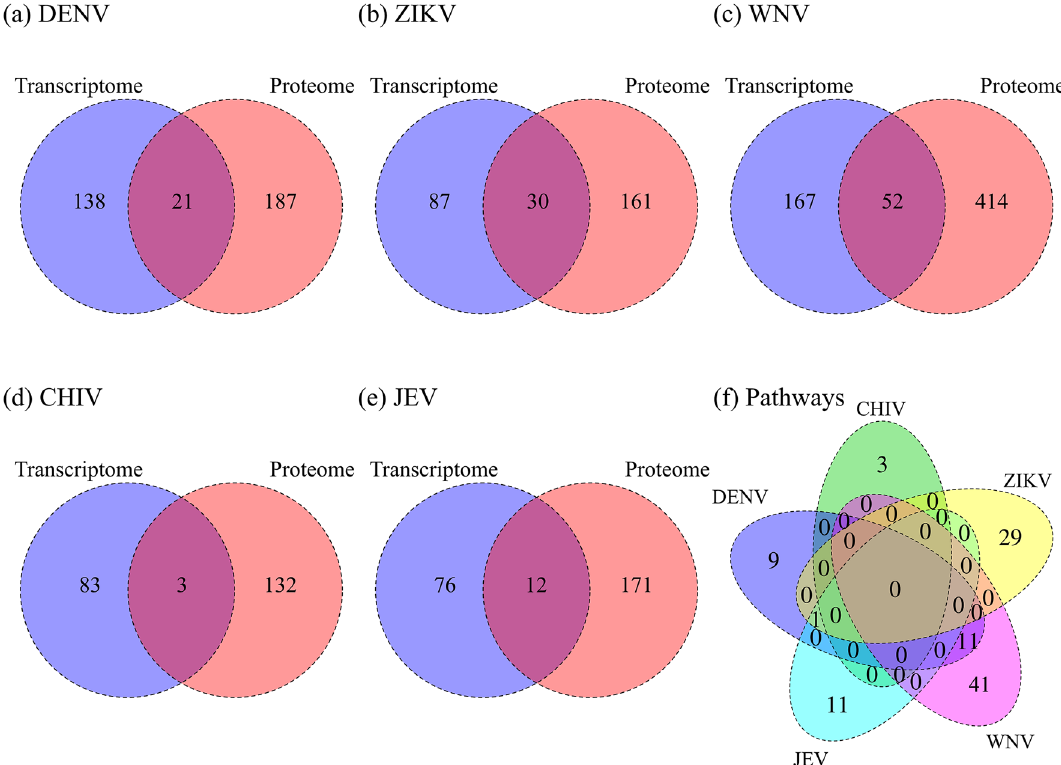
Figure 3. Signature pathways by multiple omics analyses. Venn diagrams show the overlap of the signature pathways by GSEA analysis for ( a ) DENV, ( b ) ZIKV, ( c ) WNV, ( d ) CHIV and ( e ) JEV. The number of significant pathways of the transcriptome and proteome are shown in the blue and orange circles, respectively. ( f ) Venn diagram of the signature pathways, which are intersections derived from the transcriptomic and proteomic analyses for the five viral